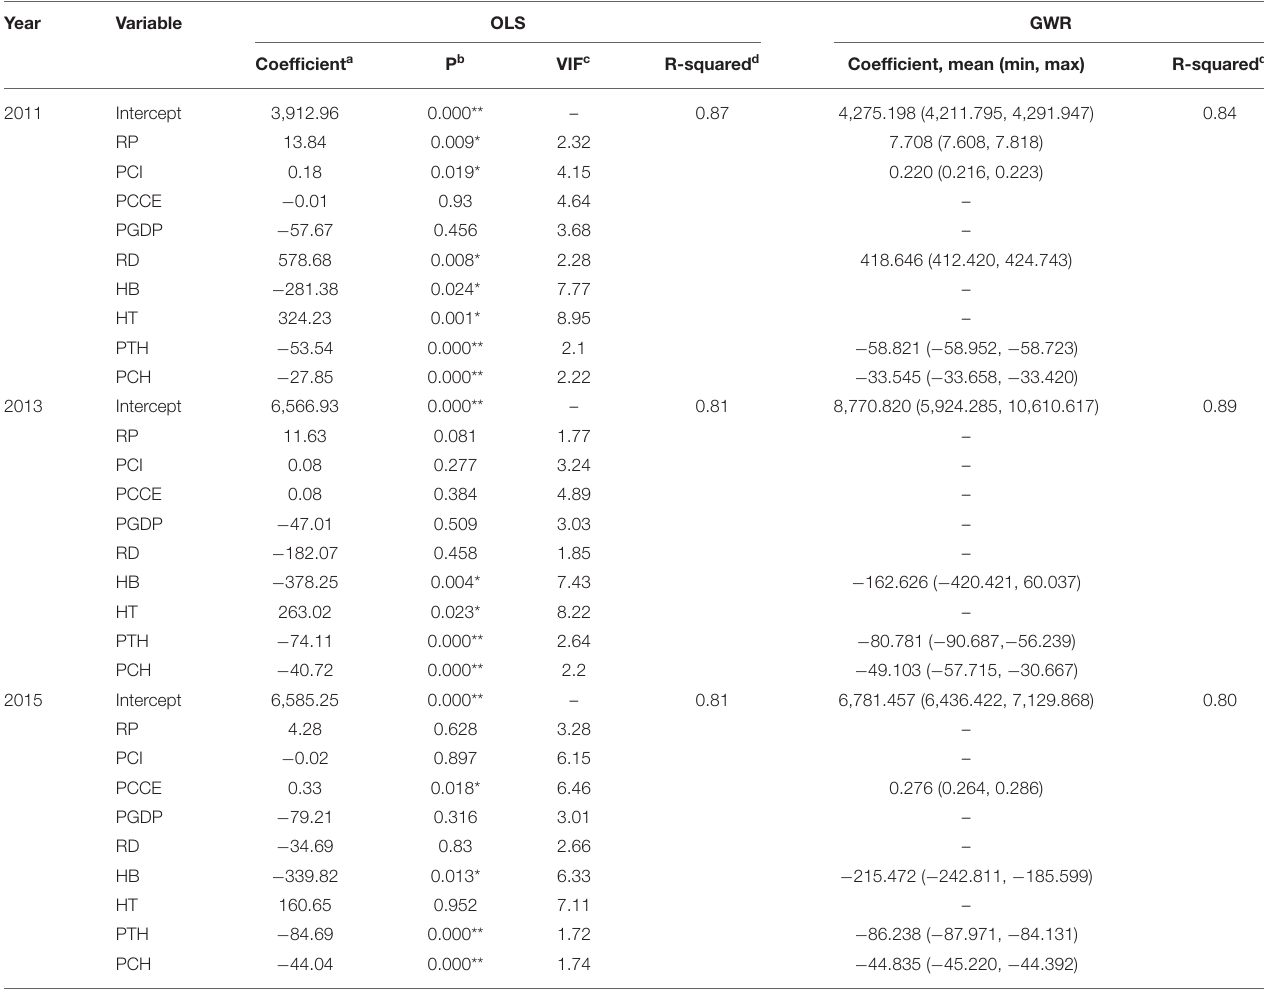
Coefficient a : represents the strength and type of relationship between each explanatory variable and the dependent variable. Probability b : the asterisk ( * ) or ( ** ) indicates a coefficient is statistically significant (p < 0.05) or (p <